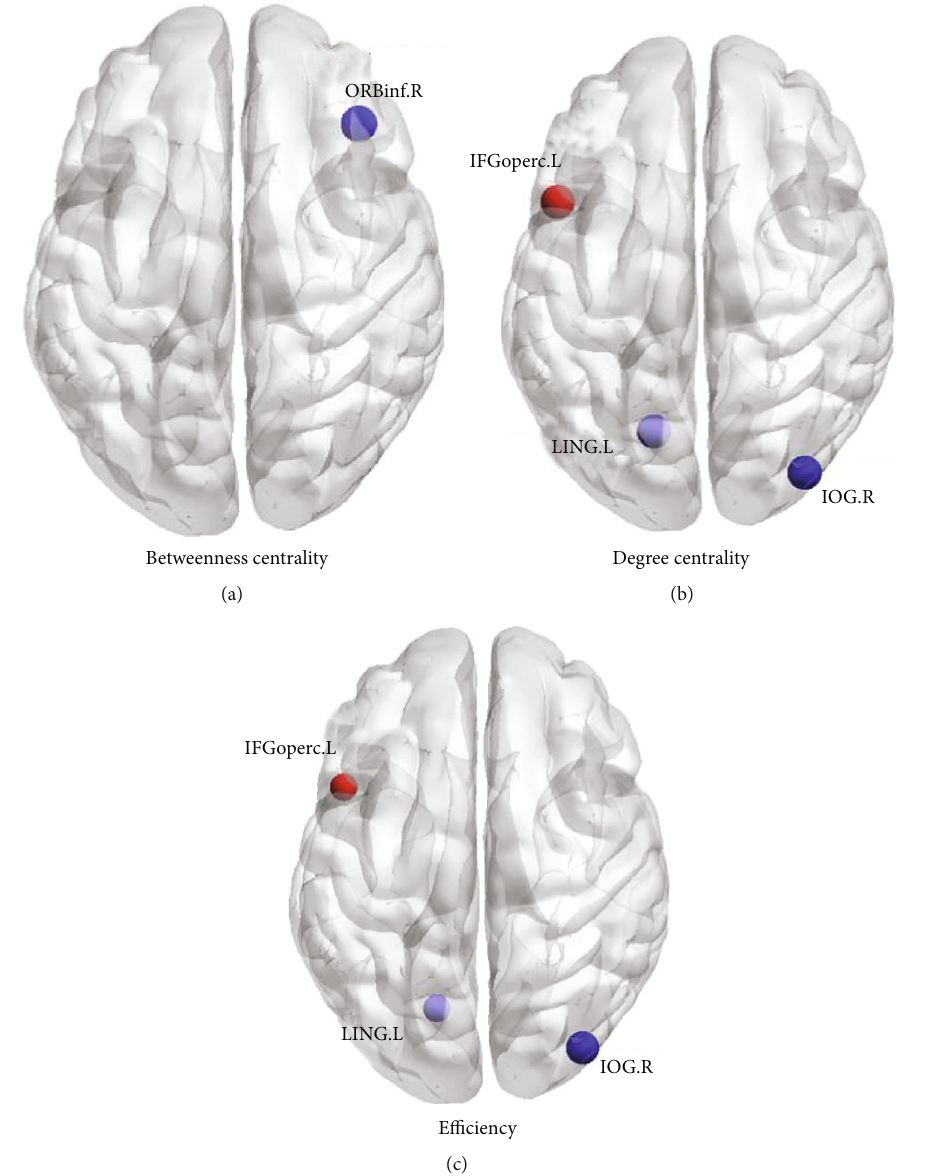
Figure 2: Di ff erences of betweenness centrality ( BC ) (A), degree centrality ( DC ) (B) and e ffi ciency ( E ) (C) of a node between lumbar disc herniation (LDH) induced nerve root(s) compression patients and healthy control subjects. The red balls represent increased values of nodal properties in the LDH group while the blue balls represent decreased, compared with the healthy control (HC) group. The size of ball represents signi fi cance, with bigger balls indicating smaller p -values. R: right; L: left; ORBinf: inferior frontal gyrus, orbital part; IFGoperc: inferior frontal gyrus, opercular part; LING: lingual gyrus; IOG: inferior occipital gyrus. Table 2: Brain regions with signi fi cant di ff erent betweenness centrality (BC) between LDH induced nerve root(s) compression and healthy control groups. Brain region p- value (uncorrected) HC > LDH ORBinf.R 0.001 LDH: lumbar disc herniation; HC: healthy control; R: right; ORBinf: inferior frontal gyrus, orbital